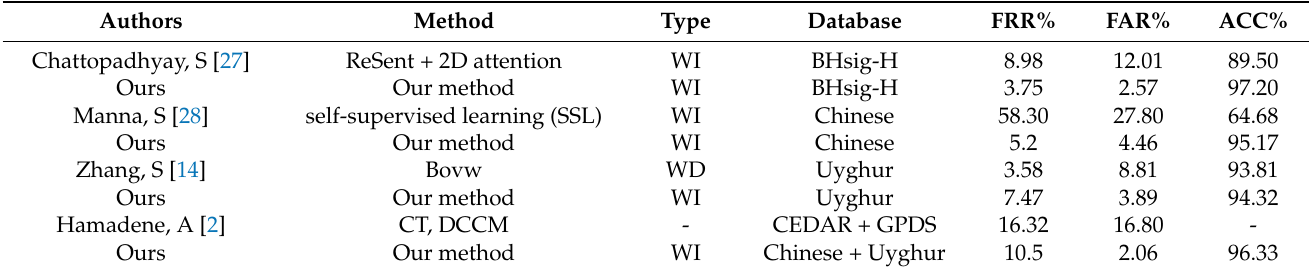
Table 5. Comparison of other research